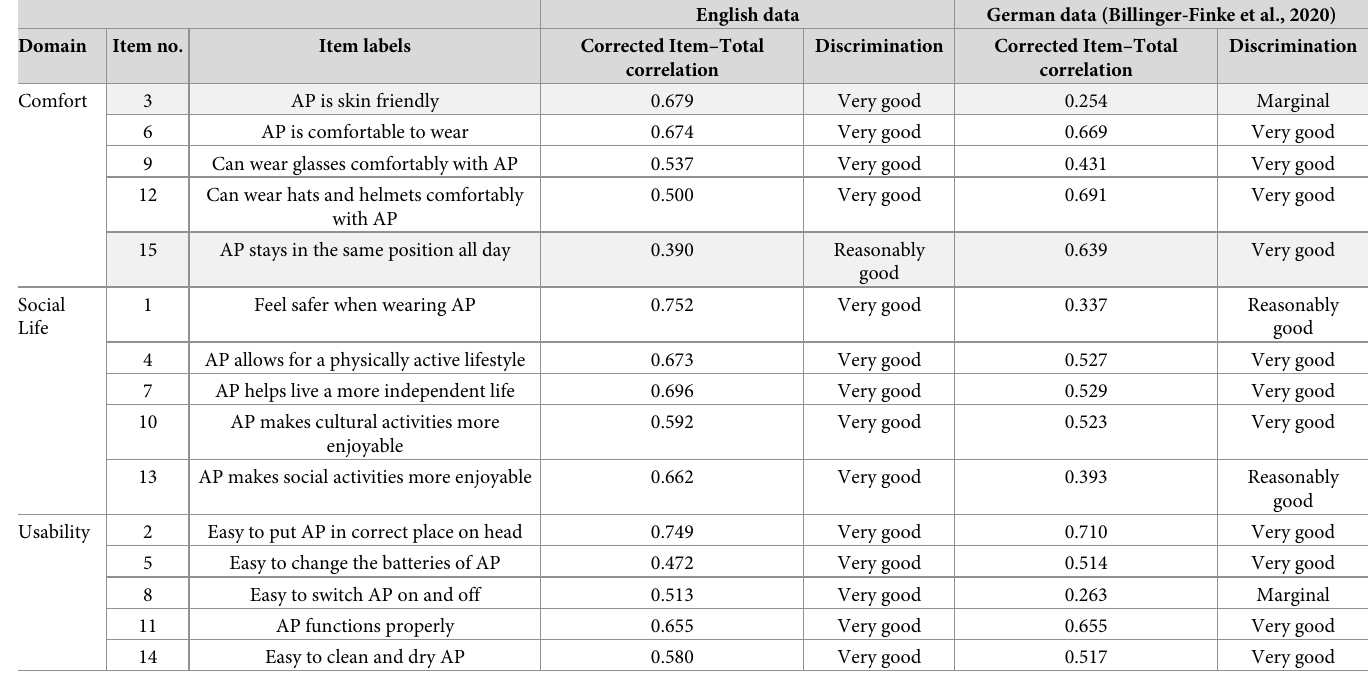
Table 2. Results from the item discrimination test. AP = audio